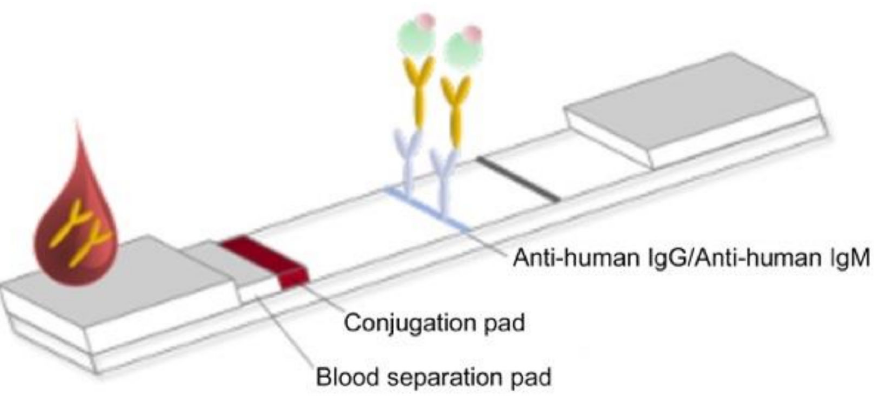
Figure 1. Schematic representation of the test strip for measuring anti-severe acute respiratory syndrome coronavirus 2 (SARS-CoV-2) immunoglobulin G (IgG) and immunoglobulin M